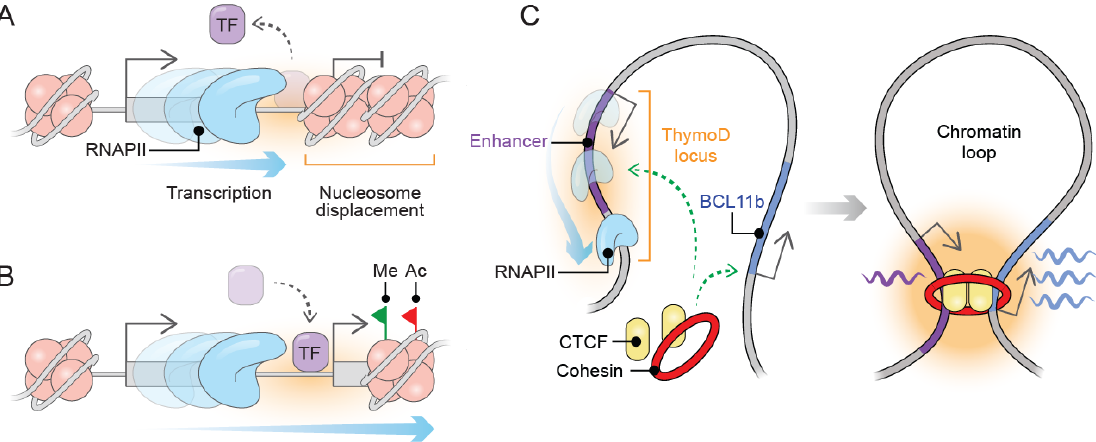
Figure 1. Transcription from lncRNA loci remodels the chromatin landscape to induce gene regulation. ( A ) The act of transcription from lncRNA loci can induce gene silencing transcriptional interference, which leads to increasing nucleosome density downstream from transcribed lncRNA loci to physically prevent TF binding and avoid the access of RNAPII machinery. ( B ) Chromatin landscape can be reprogrammed by lncRNA transcription. Overlapped transcription drives the deposition of histone modifications and dynamic TF binding. ( C ) Local chromatin folding can be restructured through the dynamic binding of structural proteins. Transcription from ThymoD locus overlaps an enhancer element, which leads to CTCF/Cohesin binding to the enhancer and the downstream BCL11b promoter, allowing promoter-enhancer interaction throughout a chromatin looping structure. Transcription factors (TF), RNA polymerase II (RNAPII), histone methylation (Me), and histone acetylation (Ac).